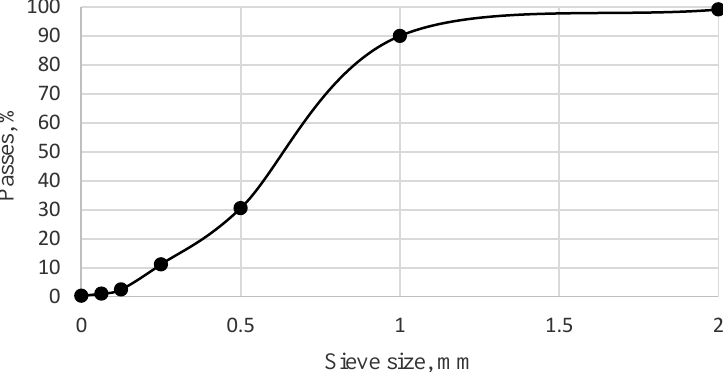
Figure 1. The particle size distribution of sand. Table 3. Properties of the fine